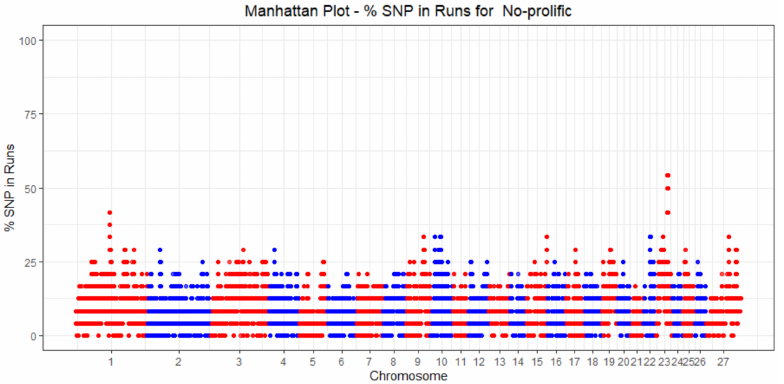
Figure 3. Manhattan plot of the frequencies (%) of SNPs in homozygosity runs in prolific Pelibuey sheep.